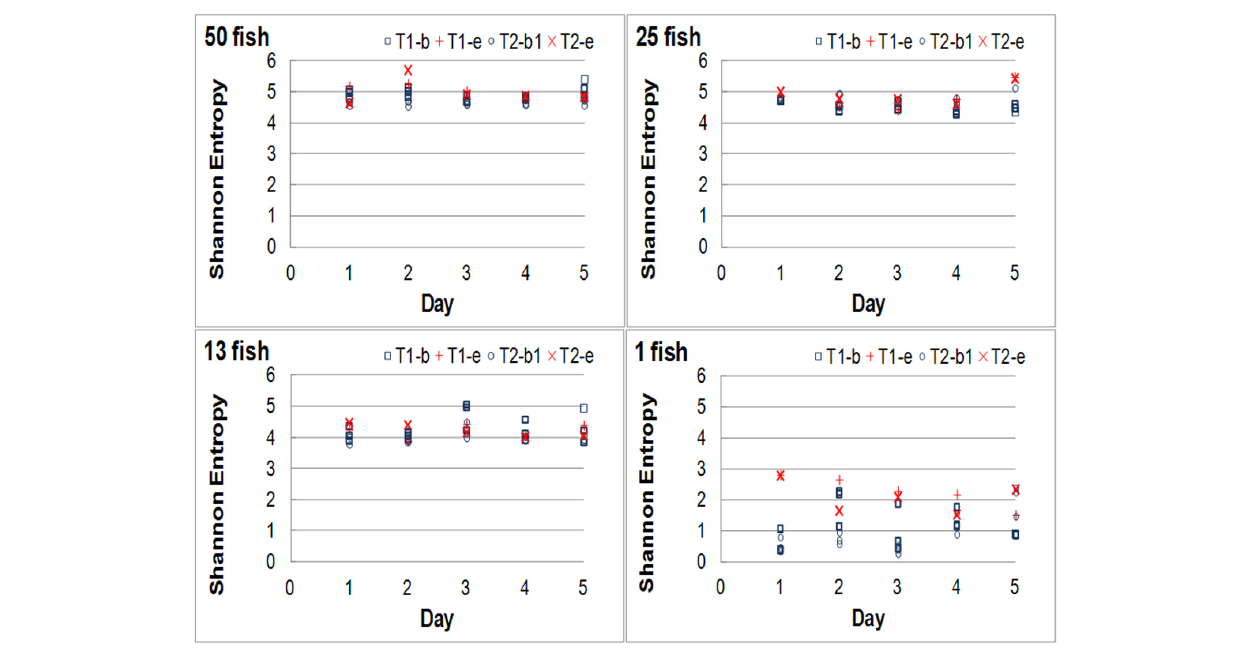
FIGURE 5 | Daily evolution of the Shannon entropy (SE) for Experiment A showing the SE values obtained in tanks 1 and 2 for the basal state (T1-b and T2-b) and in response to the stochastic event (T1-e and T2-e). The number of individuals is indicated on the Top-Left of each plot. TABLE 5 | Curve fitting parameters and goodness of the fit of the Shannon entropy (SE) vs. fish number. y = a . x b + c Basal 95% confidence